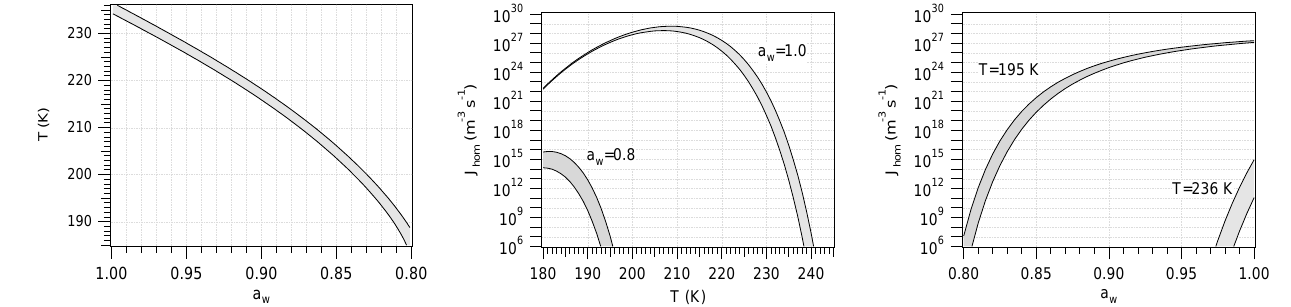
Figure 8. Estimated range of variability in T f ( D p = 10µm and 1t =10) and J hom for the NNF model. Fig. 8. Estimated range of variability in T belong to the interface (which is likely an upper limit of vari- ability) will increase 0 w to 1.51. The factor, s , is 1.09 for hcp crystals and 1.12 for bcc crystals (Jian et al., 2002) and it is not likely that s would be outside of this range. Figure 8 shows the expected variation in J hom from variation in 0 w and s within these intervals. It represents between 1 and 3